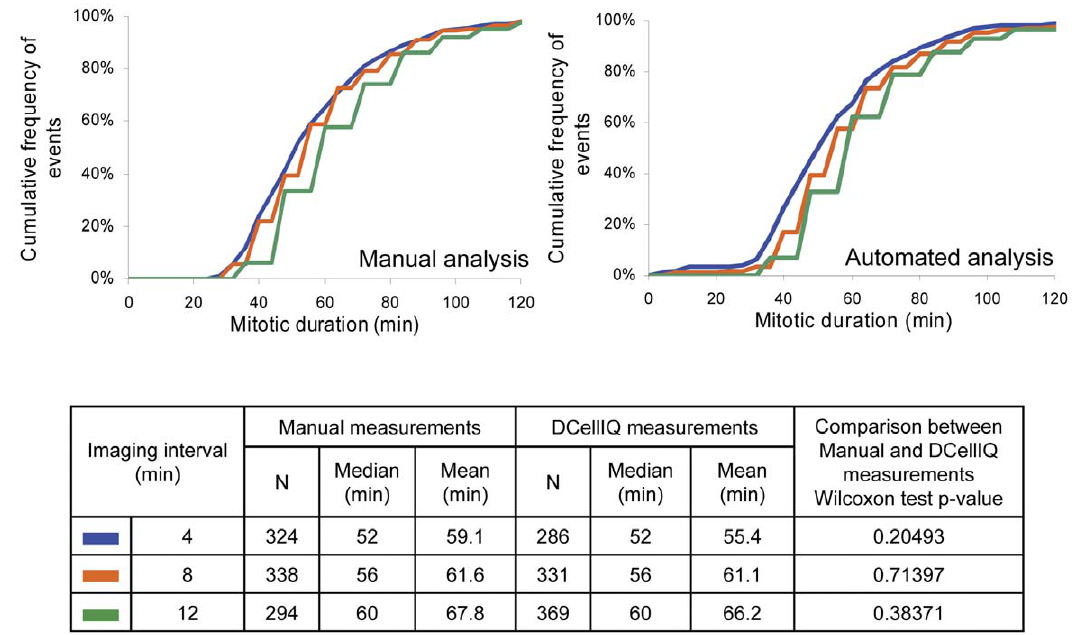
Figure 2. The choice of imaging frequency influences measurement of mitotic duration. HeLa H2B-GFP cells were imaged every 4 minutes for 24 hours and all images (4 min interval) or selected images (8 or 12 min intervals) were analyzed with the automated approach. For each condition 4 fields in 2 independent wells were imaged and the results for the 8 images series were combined. Half of the movies were analyzed manually for comparison. Cumulative frequency curves of events are depicted as a function of mitotic duration for the different intervals. The number of detected mitotic events (N), measured median and mean mitotic duration are provided.